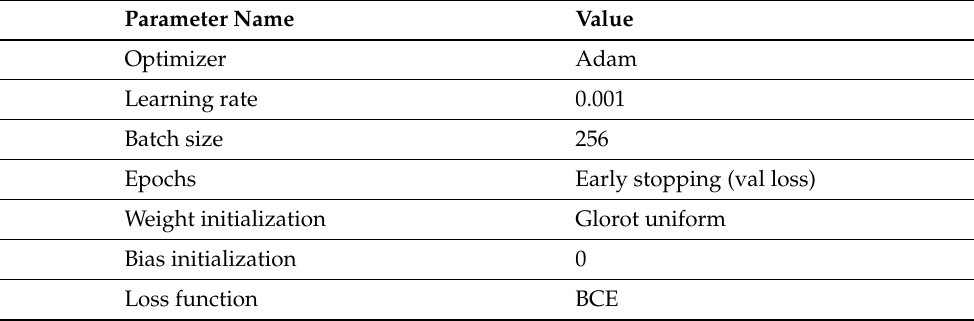
Table 6. Training hyperparameters of